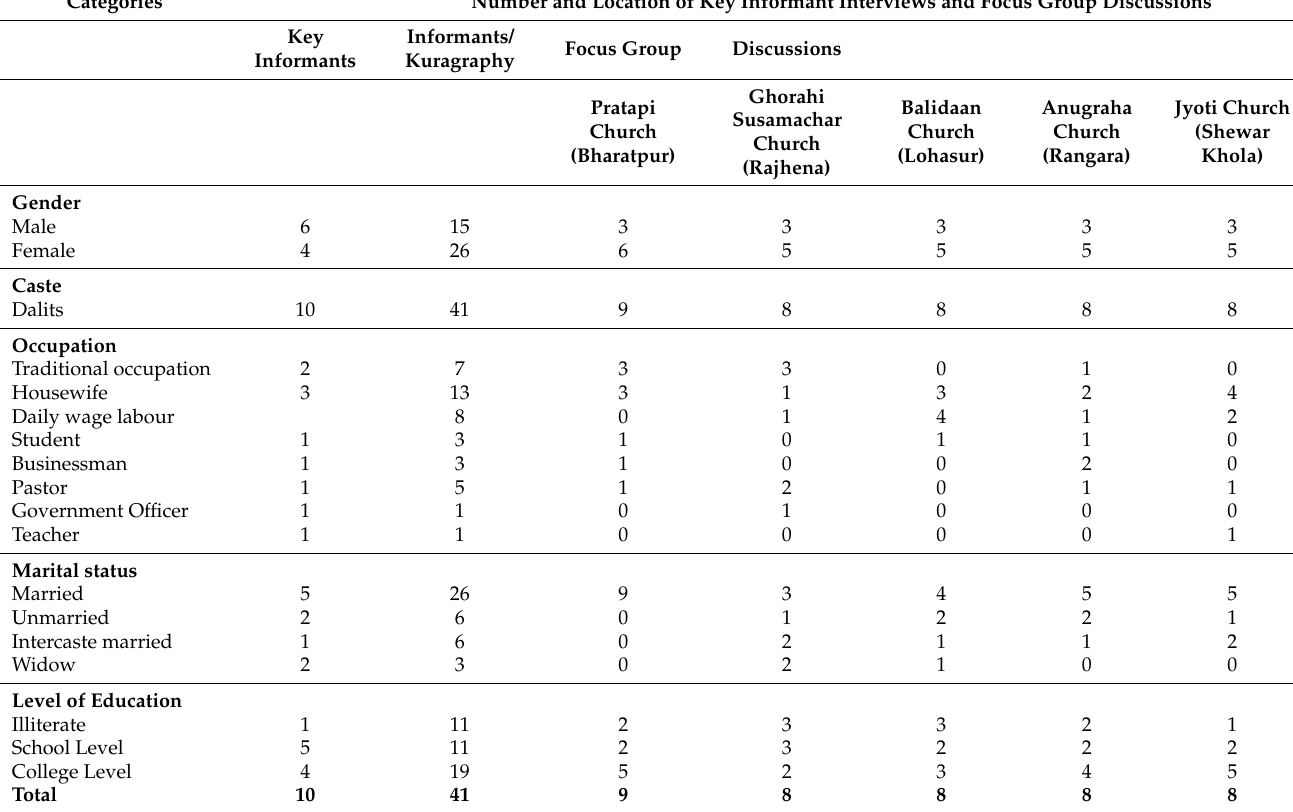
Table 1. Characteristics of the